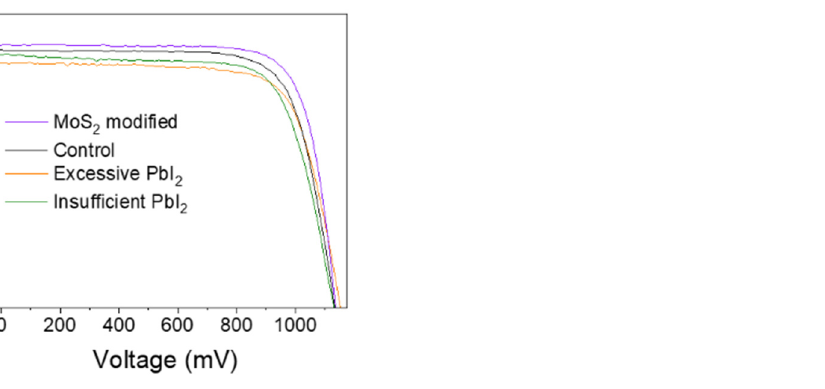
Figure 10. J–V curves of device with 5% excess PbI 2 , device with MoS 2 , control device, and MoS 2 modified device.